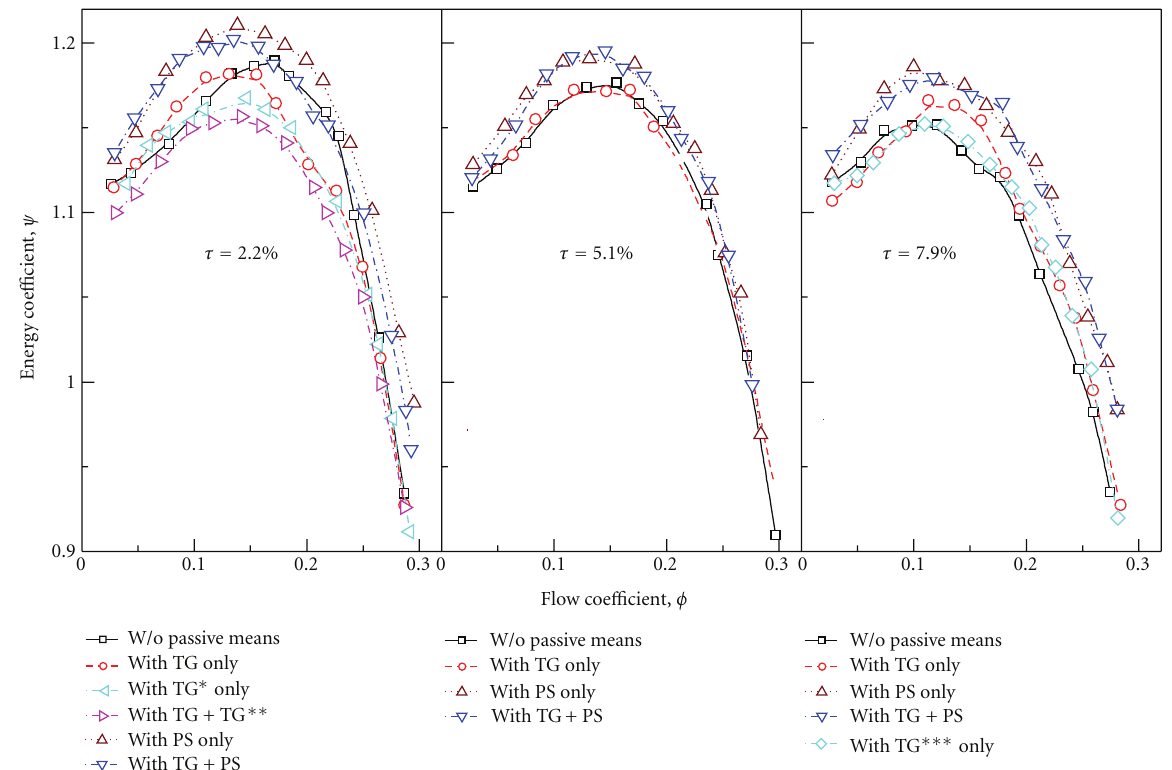
Figure 3: Performance characteristics of the centrifugal compressor ( ψ versus φ ): e ff ect of